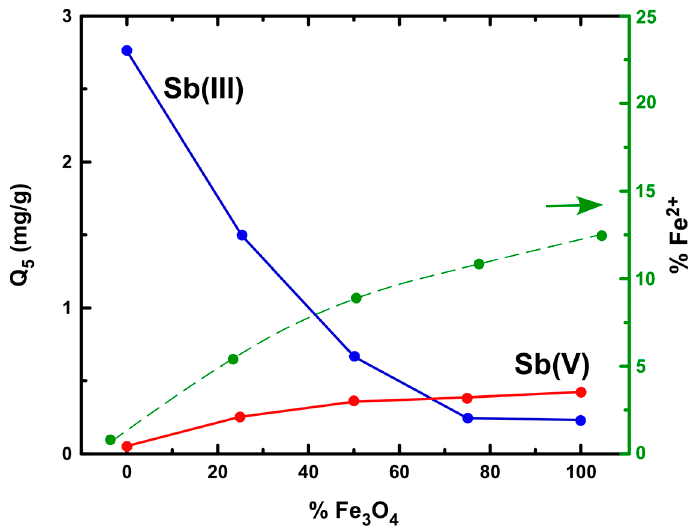
Figure 7. Variation of adsorption capacity for Sb(III) and Sb(V) corresponding to the drinking water regulation limit for the studied Fe 3 O 4 /FeOOH nanocomposites. The evolution of Fe 2+ percentage with Fe 3 O 4 content is also indicated.